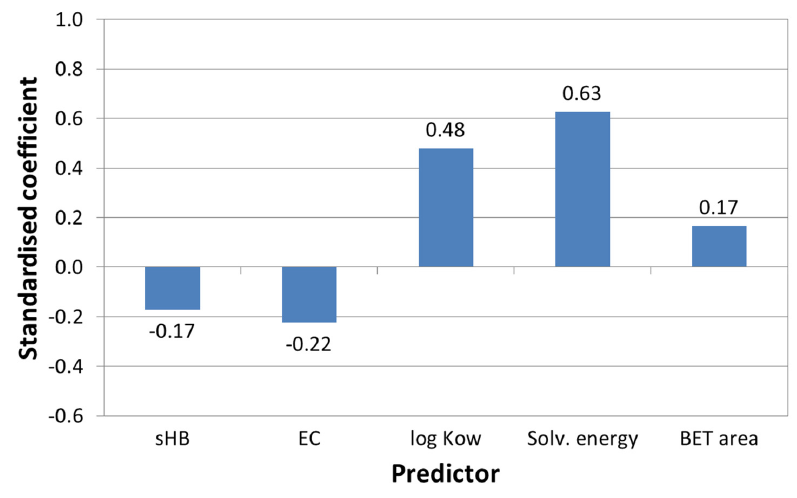
Figure 6. Standardised coefficients of the five parameters’ model fitting (21 h batch adsorption).